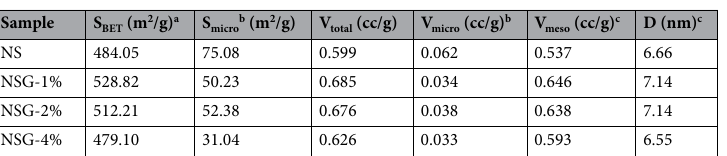
Table 2. Textural properties of samples. a S BET (surface area) by BET method, measured at P/P0 < 0.3 b S micro and V micro by t-plot method. c S meso and D meso by DFT